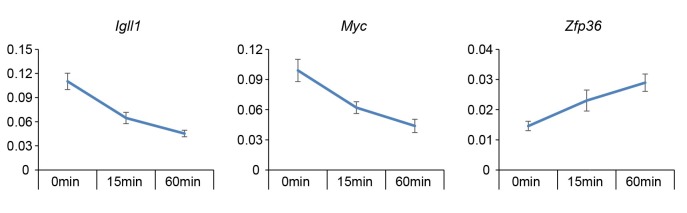
Transcriptional regulation by Ikaros-ERt2 in the absence of endogenous Ikaros.B3 cells with disrupted endogenous Ikzf1 alleles were transduced with Ikaors-ERt2. Primary transcripts for Igll1, Myc, and Zfp36 were measured at the indicated times after 4-OHT addition. MeanDOI: